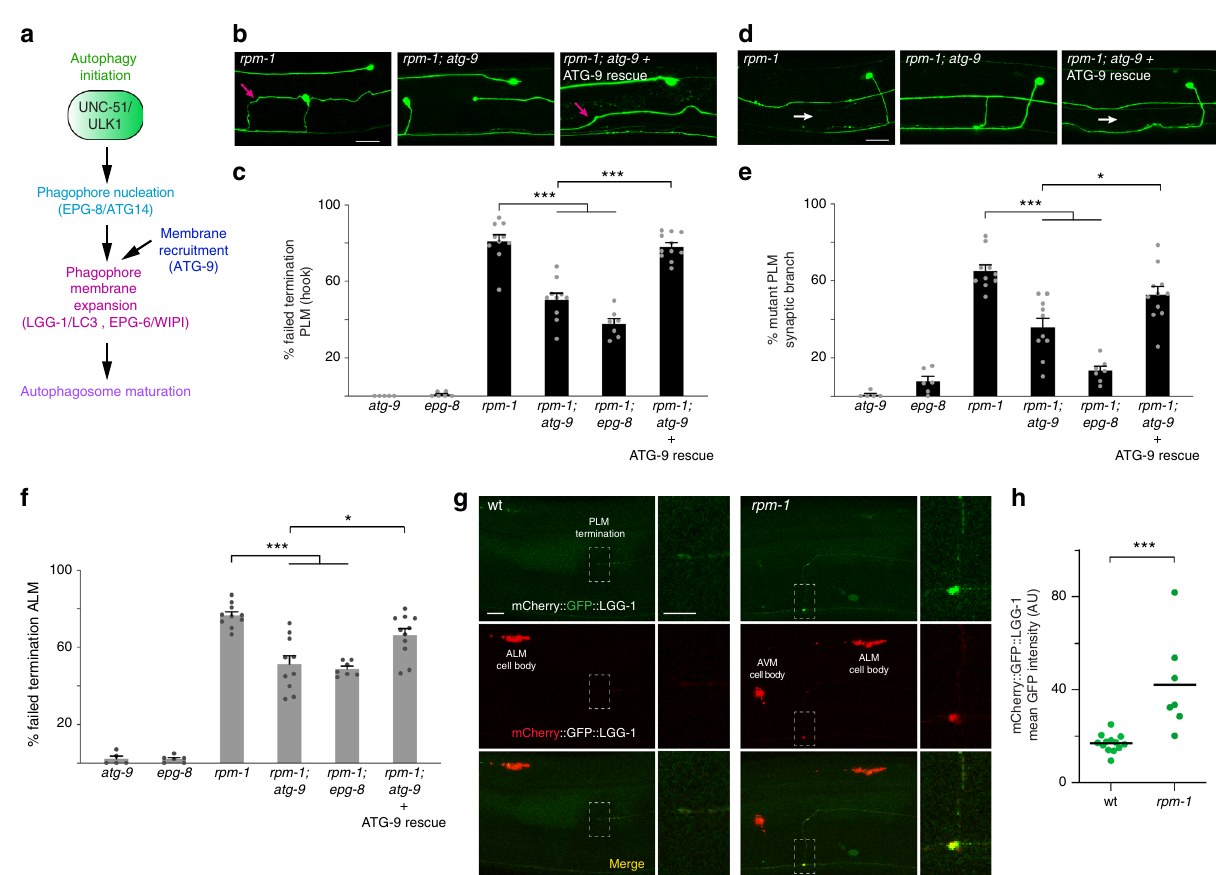
Fig. 7 RPM-1 regulates axon termination and synapse maintenance by inhibiting autophagosome formation in axonal compartments. a Summary of steps in autophagy. b Representative images of PLM axons for indicated genotypes visualized using transgenic GFP. Severe failed termination defects (magenta arrow) in rpm-1 mutants are suppressed in rpm-1; atg-9 animals and rescued by ATG-9 expression in mechanosensory neurons. Scale bar 20 μ m. c Quantitation of failed termination defects (hook) in PLM neurons for indicated genotypes. PLM termination defects are suppressed in rpm-1; atg-9 and rpm-1; epg-8 . d Representative images of PLM synaptic branch and presynaptic boutons for indicated genotypes. Synapse maintenance defects (synaptic branch retraction, white arrows) that occur in rpm-1 mutants are suppressed in rpm-1; atg-9 animals and rescued by expressing ATG-9 in mechanosensory neurons. Scale bar 20 μ m. e Quantitation of synapse maintenance defects for indicated genotypes. Synapse maintenance defects are suppressed in rpm-1; atg-9 and rpm-1; epg-8 . f Quantitation of failed termination defects in ALM neurons for indicated genotypes. ALM termination defects are suppressed in rpm-1; atg-9 and rpm-1; epg-8 . g Representative images of mCherry::GFP::LGG-1/LC3 expressed in mechanosensory neurons using MosSCI. At right, zoomed-in images for highlighted regions (hatched boxes). GFP signal marks autophagosomes, and is lost in low pH autolysosomes where only mCherry signal occurs (ALM and AVM cell bodies). Low GFP signal at axon termination sites in wt animals. GFP-positive puncta accumulate at tips of axons with failed termination in rpm-1 mutants. Scale bar 10 μ m (zoom-out, left) and 5 μ m (zoom-in, right). h Quantitation indicates GFP signal from mCherry::GFP:: LGG-1 is increased at tips of axons with failed termination in rpm-1 mutants compared with axon termination sites in wt animals. For c , e , and f , means are shown from 5 to 11 counts (25 – 35 animals/count) for each genotype. Signi fi cance determined using Student ’ s t -test with Bonferroni correction. For h , means are shown from seven or more animals imaged during three independent experiments for each genotype. Signi fi cance determined using Student ’ s t -test. * p < 0.05; *** p < 0.001. Source data are provided as a Source Data fi